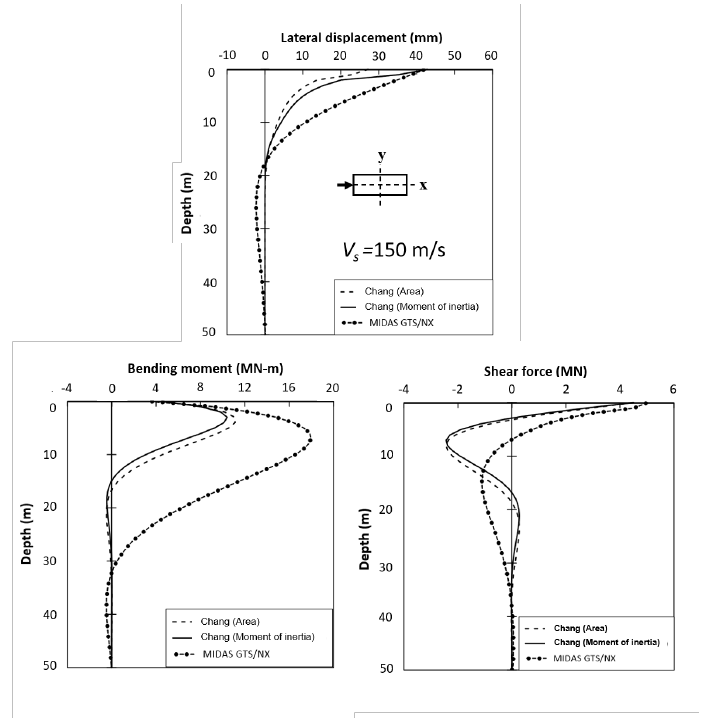
Fig. 22. Comparative solutions for barrette in sands with load in longitudinal